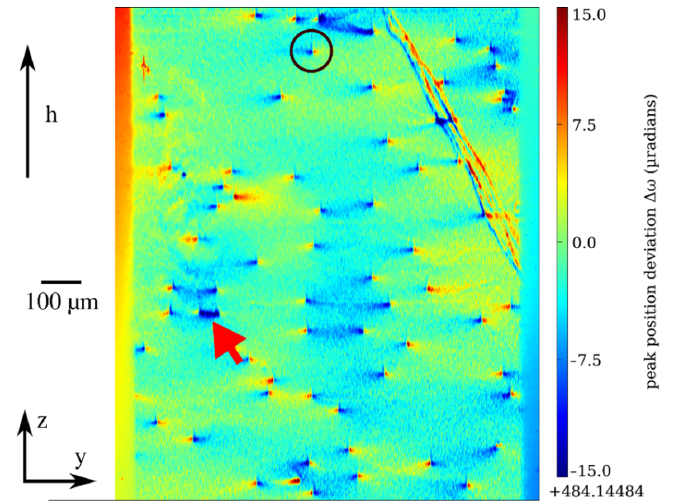
Figure 3. RCI peak position map. The black circle indicates an isolated dislocation where the peak shift ∆ ω has opposite signs on the left and right of the dislocation core. A similar pattern is observed for other isolated dislocations, the sign of ∆ ω being reversed (blue-yellow or yellow-blue) as a function of the sign of the Burgers vector of the dislocation. The red arrow indicates the pair of dislocations already pointed out in Figure 2. They display opposite Burgers vectors because the sign of their peak position variation with respect to the matrix is reversed: when going from left to right along the y direction, the change is yellow to blue for the first dislocation and blue to yellow for the second one. Note that the peak shift in the region between the dislocation cores does not decay to the value of the surrounding